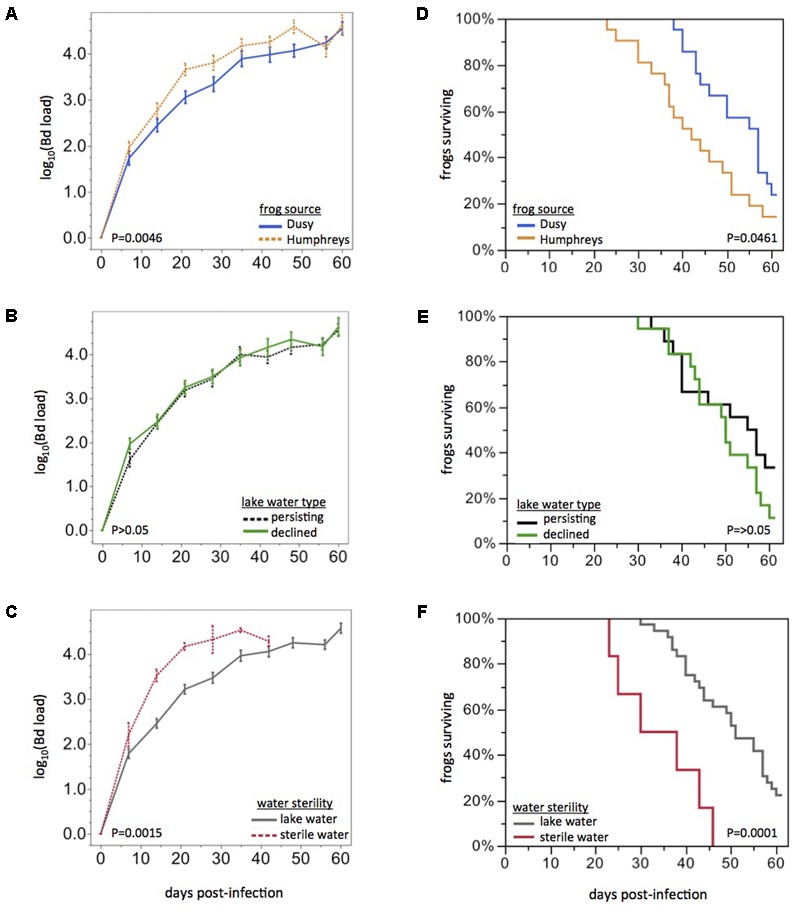
Effects of frog source and water source on disease dynamics. Bd load trajectories and survival of frogs, grouped by Frog Source (top), Lake Water Type (middle), or Water Sterility (bottom). Rates of Bd load increase and survival curves were affected by Frog Source (A,D) and Water Sterility (C,F) but not Lake Water Type (B,E). Statistical tests are based on the first 21 days post-exposure only because of missing data (due to mortality) beyond that time span. All frogs eventually developed high Bd loads.